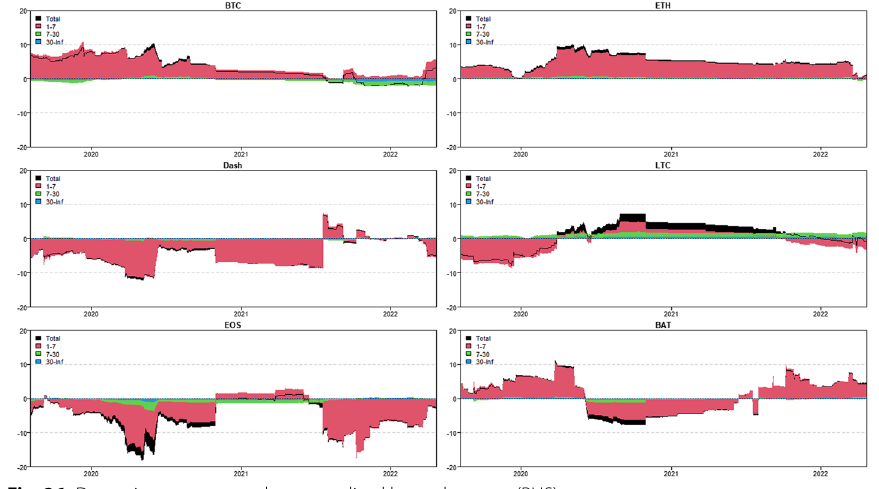
Fig. 26 Dynamic net connectedness—realized hyperskewness (RHS)